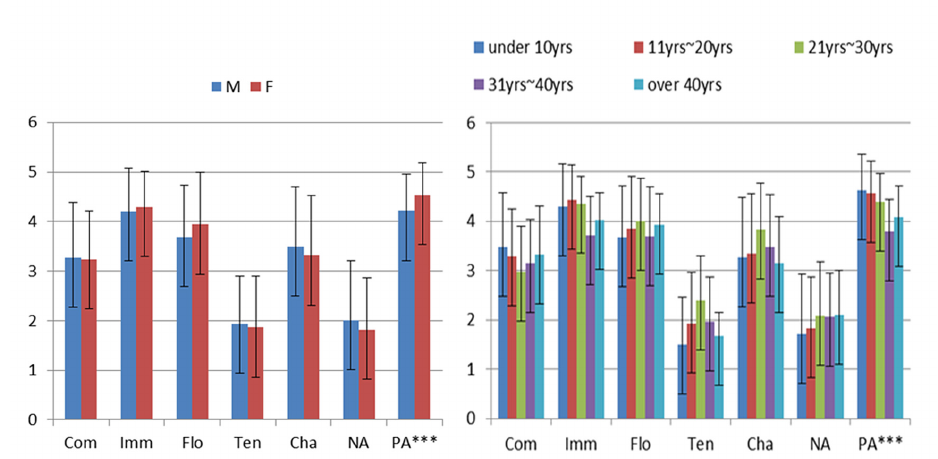
Figure 3. Means of all dimensions of the core module by gender and age groups (* = p < 0.05; * *= p < 0.01; *** = p <